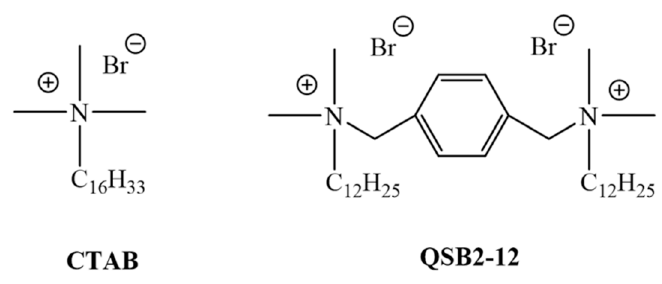
Figure 1. Structure of the cationic surfactants.